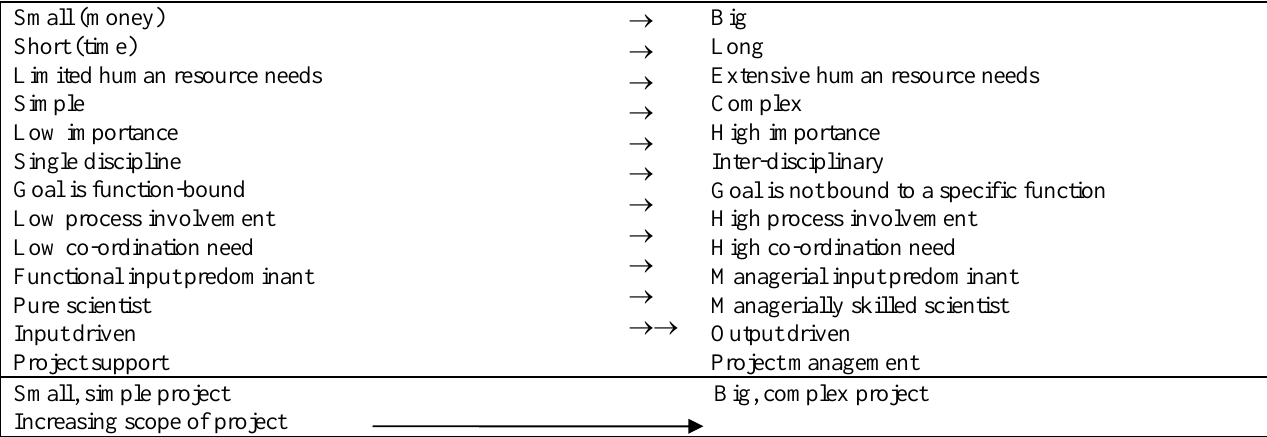
Figure 2: Continuum of project classification determinants Source: Brown